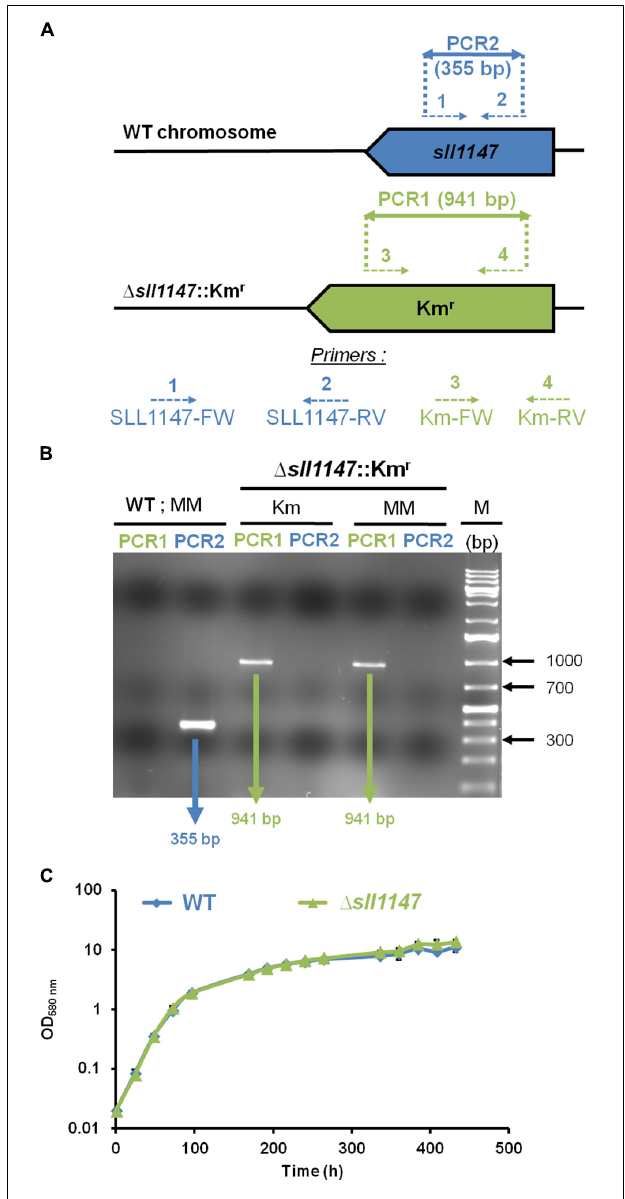
FIGURE 1 | The sll1147 gene is dispensable for the photoautotrophic growth of Synechocystis . (A) PCR analysis of the sll1147 chromosome locus in Synechocystis WT strain and the (cid:49) sll1147 :Km r mutant constructed in this study. The genes are represented by colored arrows ( sll1147 + , blue; Km r , green) pointing into the direction of their transcription. The same color code is used to represent the PCR oligonucleotides primers (dotted arrows, see Supplementary Table S1 for their sequence) and the corresponding PCR products (double arrows) typical of the presence of WT ( sll1147 + and Km S ) or mutant ( (cid:49) sll1147 : Km r ) chromosome copies. (B) Typical UV-light image of the agarose gel showing the PCR products corresponding to the genes sll1147 + (PCR2, blue) or Km r (PCR1, green) generated from WT and (cid:49) sll1147 : Km r cells grown in absence (MM) or presence (Km) of the selective antibiotic. M (marker DNA) stands for the GeneRuler 1 kb Plus DNA Ladder (Thermo Fisher Scientific). Note that WT cells harbor only WT chromosomes while (cid:49) sll1147 :Km r mutant cells possess only (cid:49) sll1147 :Km r chromosomes. (C) Typical growth curves of the WT strain and sll1147 mutant growing under standard photoautotrophic